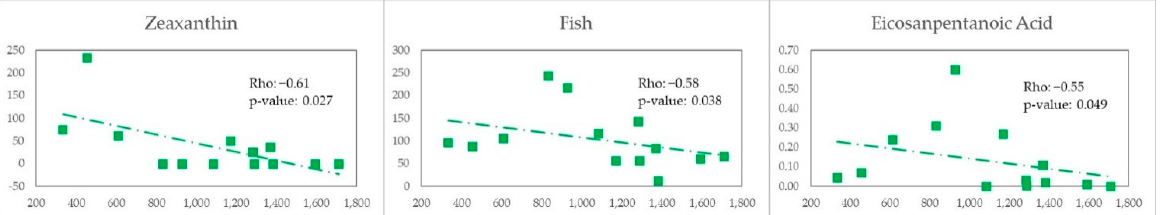
Figure 9. Scatter plot X—Erysipelotrichaceae, Y—Nutrients/Food for MSM-MEL.